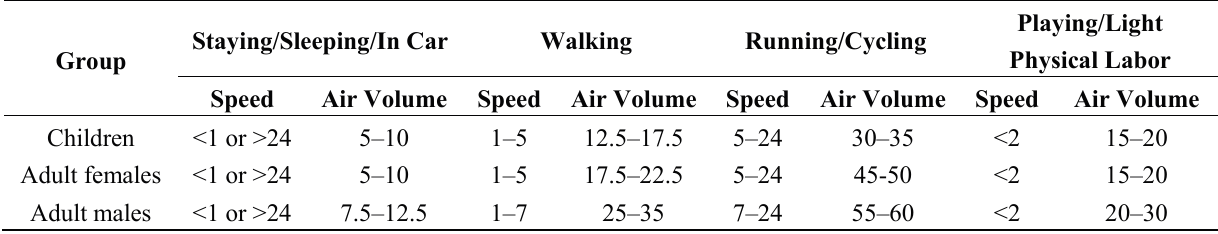
Table 2. Individual average air intake volume per minute (adapted from Holmes 1994 [15]).